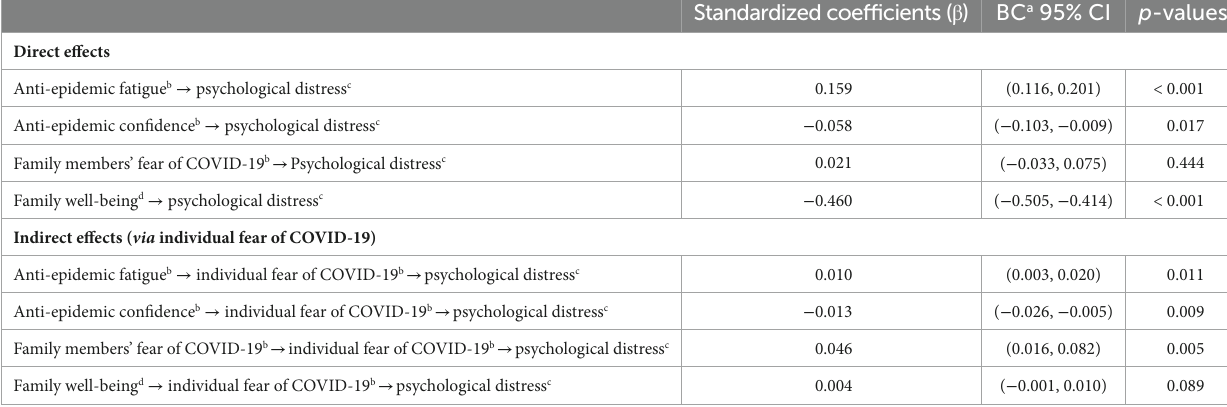
TABLE 3 Direct and indirect effects in the structural equation